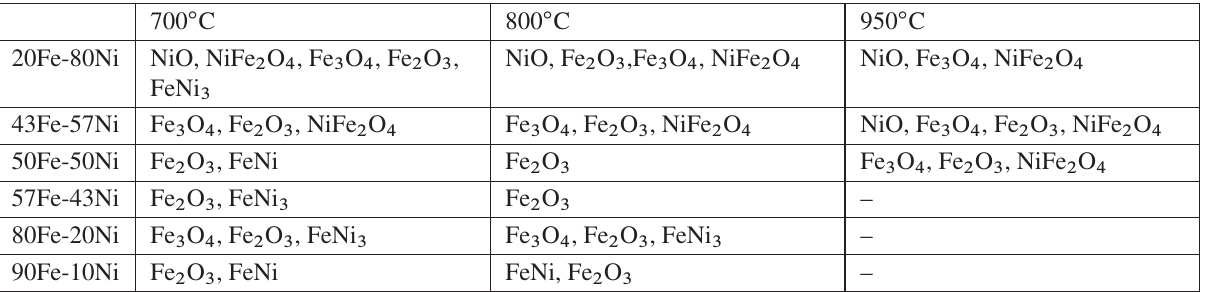
Table 2. Phases of Fe-Ni alloys after oxidation at 700 ı C, 800 ı C and 950 ı